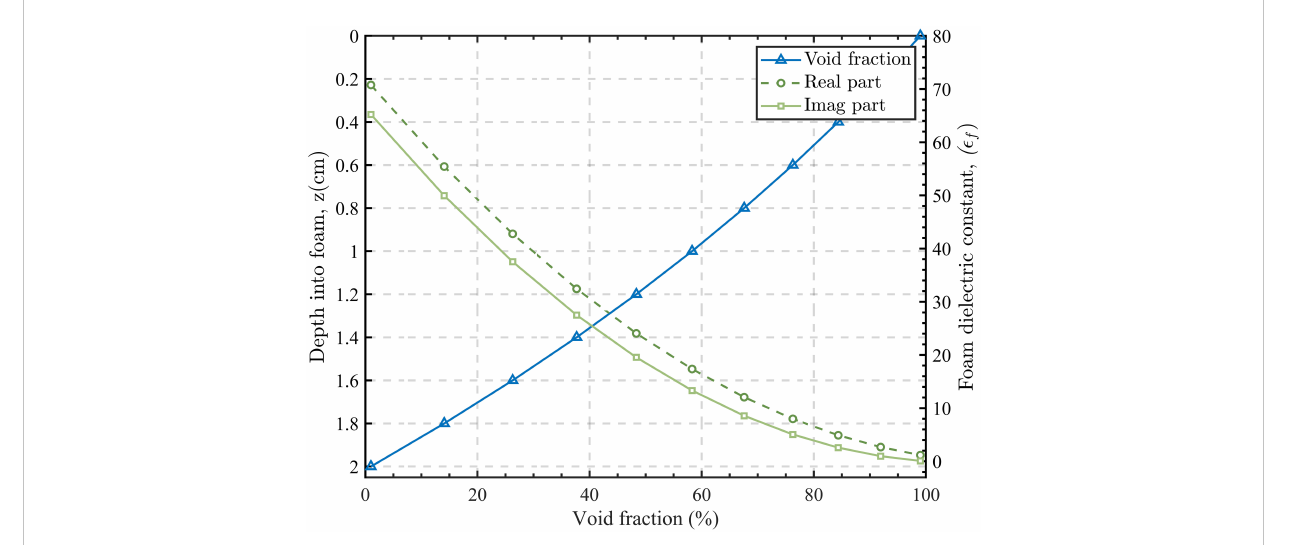
FIGURE 2 Void fraction pro fi le of the foam layer with thickness z = 2 cm and complex permittivity of sea foam obtained with the refractive mixing rule as a function of the void fraction at 1.4